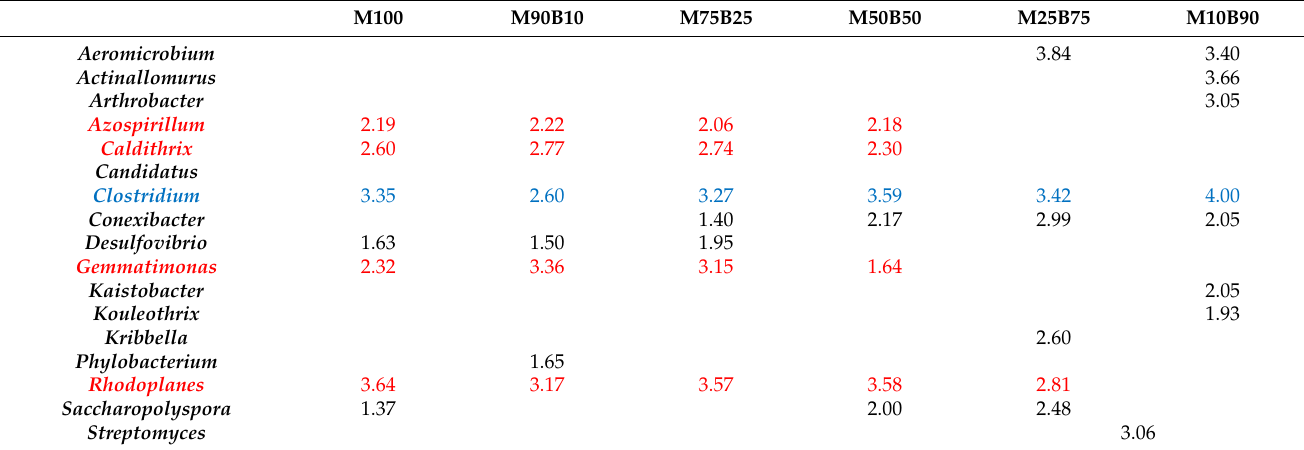
Table 8. Genus classification for mud compost (M) blended with biochar (B) by percent of total nucleic acids in the sample